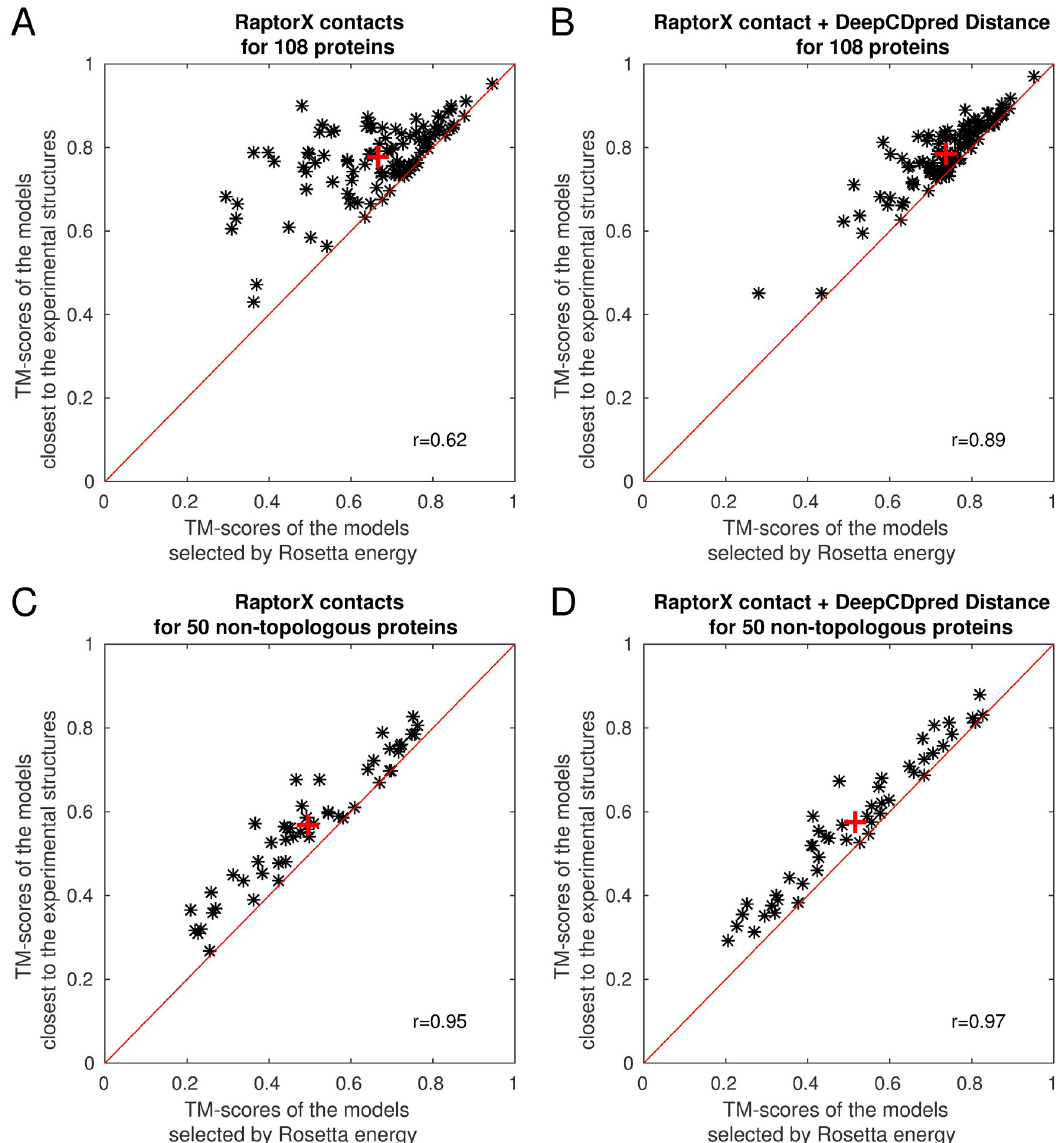
Fig 4. The models with the lowest Rosetta energies, when using distance together with contact constraints, are closer to the best model in the ensemble of models than when using contact constraints alone. For each test protein 200 structures were generated by Rosetta. The red ‘+’ sign indicates the average